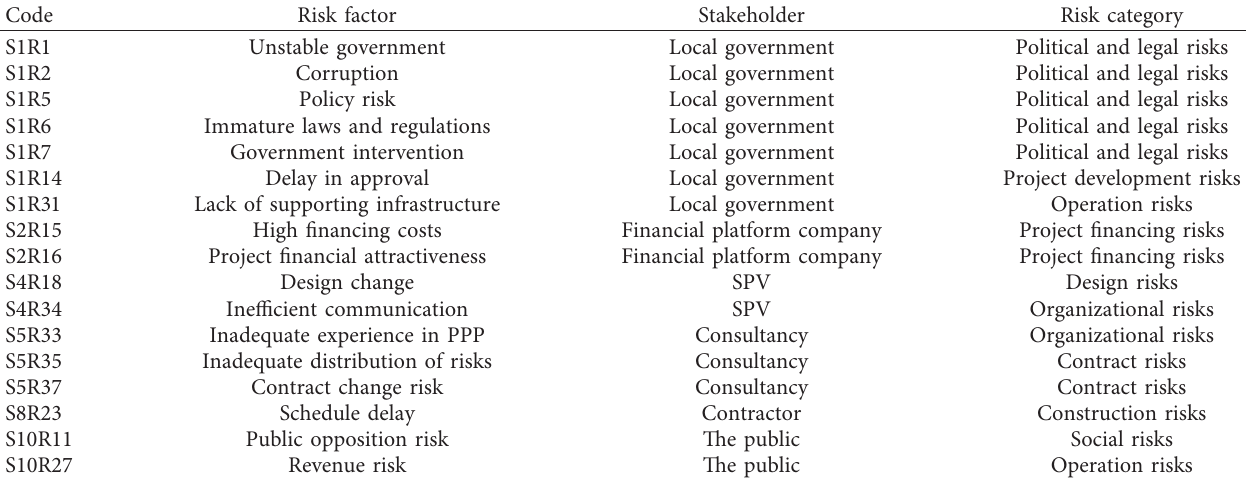
Table 9: Critical risk factors in the case PPP